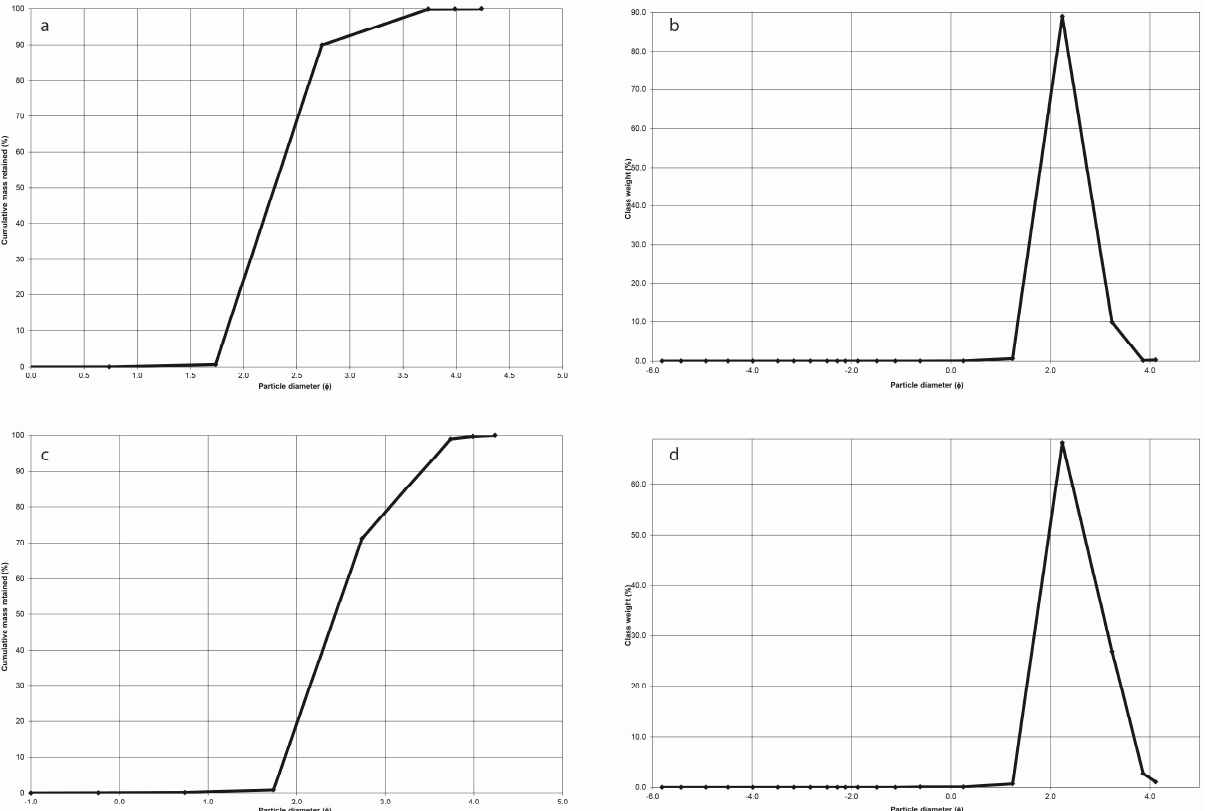
Figure 9. Cumulative (phi) and Distribution (phi) curves. ( a , b ) sample AK13/SD. ( c , d ) sample